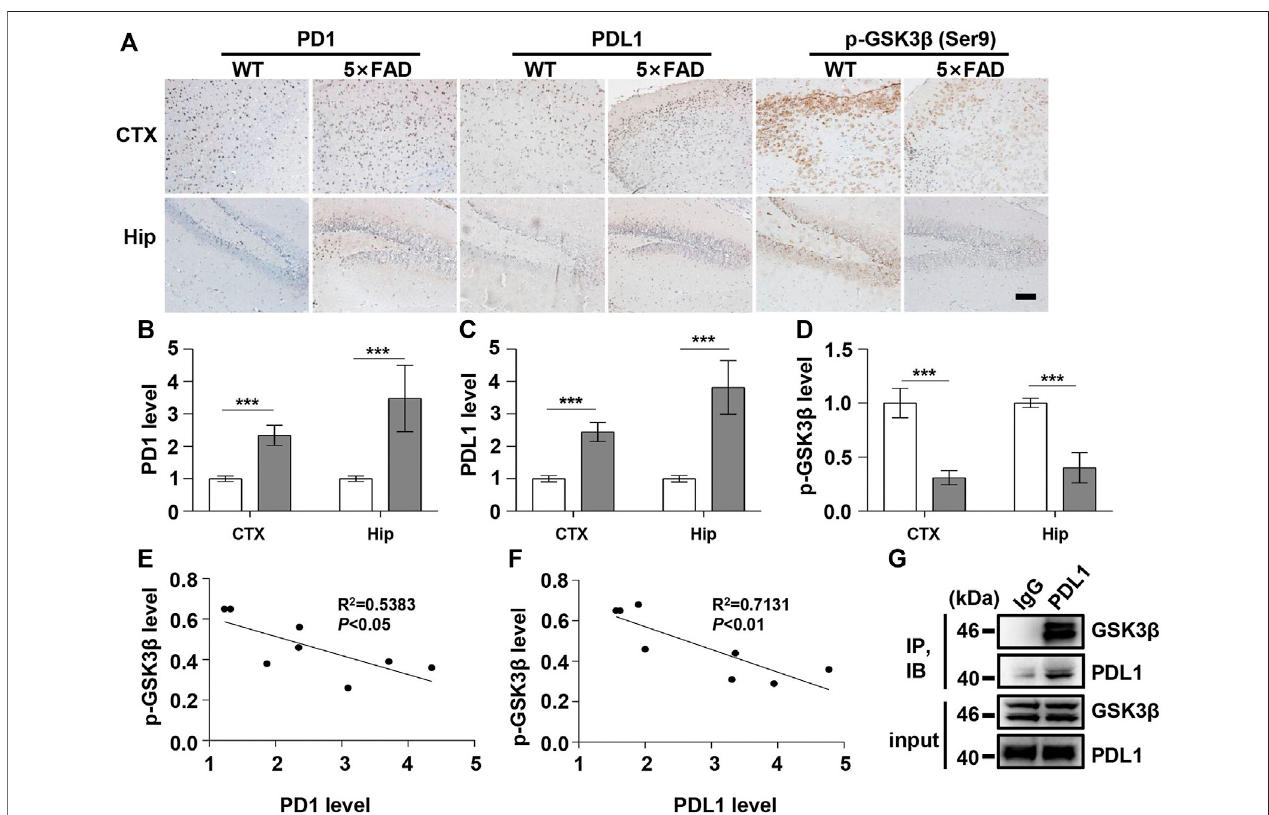
FIGURE3| PD1andPDL1levelswereelevatedinthebrainof5 × FADmice.MaleWTand5 × FADmice(averageage9 – 10 months,n (cid:2) 8/group)weresacri fi cedand their brain tissues were harvested. (A – D) Immunohistochemistry analysis using the anti-PD1, anti-PDL1 antibody, and p-GSK3 β (Ser9) antibodies was performed with paraf fi n-embedded brain sections from WT and 5 × FAD mice. *** p < 0.001; paired t -test, scale bar (cid:2) 100 μ m. (E,F) Correlation between the hippocampal p-GSK3 β (Ser9)levelonthe Y -axisandthecorrespondingPD1orPDL1levelonthe X -axis(R 2 (cid:2) 0.5383, p < 0.05,orR 2 (cid:2) 0.7131, p < 0.01,respectively,Pearsoncorrelation coef fi cient). (G) WT mouse brain lysates were precipitated with nonspeci fi c IgG or anti-PDL1 antibodies and probed with anti-GSK3 β